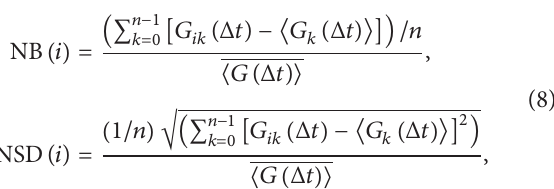
of the NIMS-XPOL at 2101UTC, July 10, DP